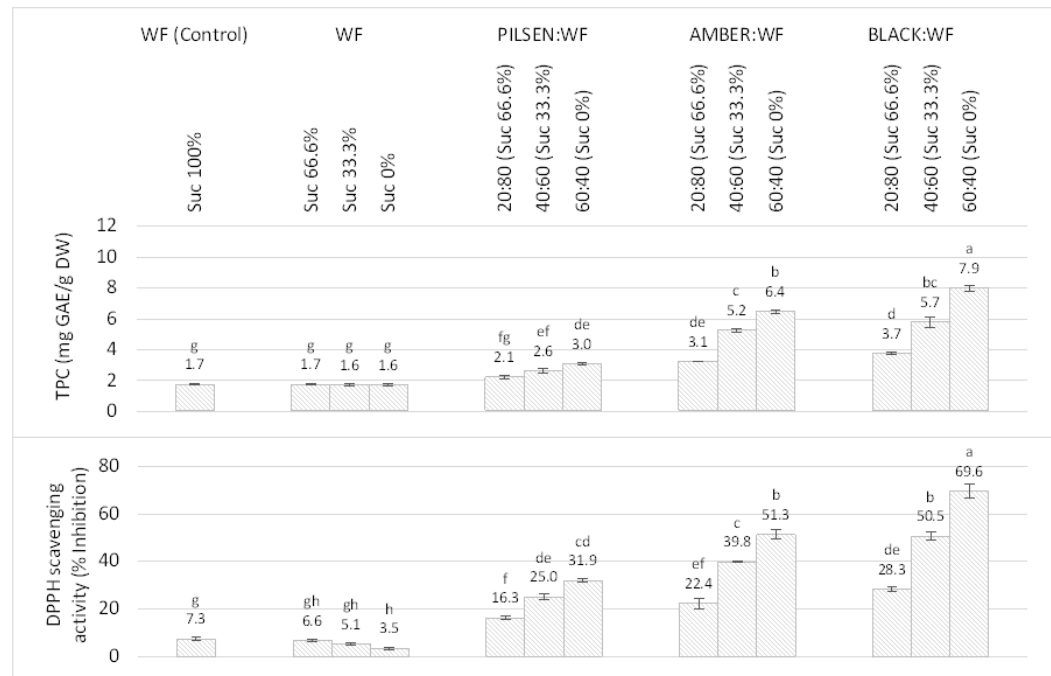
Figure 5. Total phenolic content (TPC) and antioxidant activity (AOA) of cookies made from malted barley and wheat composite flours with reduced sucrose addition. WF—Wheat flour. Suc%: Per- centage of added sucrose compared to standard recipe. The values are Mean ± SD ( n = 3). Different letters (a–h) indicate statistically significant differences ( p < 0.05).